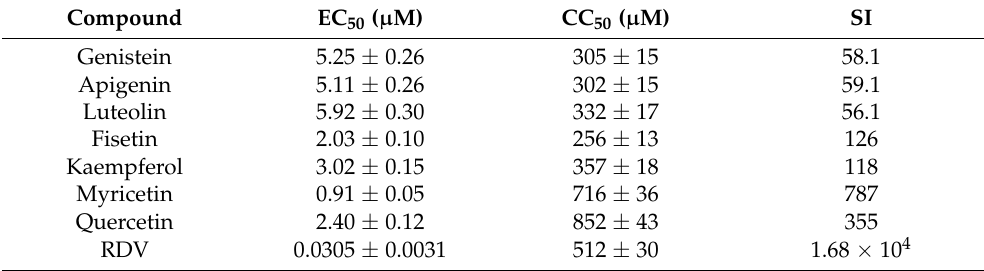
Figure 2. Antiviral activity of flavonoids and RDV (positive control). ( A ) SARS-CoV-2 production and ( B ) inhibition of SARS-CoV-2 replication in Calu-3 cells (densities of 2.0 × 10 5 cells/well) infected with SARS-CoV-2 B.1 lineage at a MOI of 0.1. Table 1. The 50% effective concentration (EC 50 for MOI 0.1), 50% cytotoxic concentration (CC 50 ), and selectivity index (SI) for the flavonoids and RDV (positive control) in Calu-3 cells.